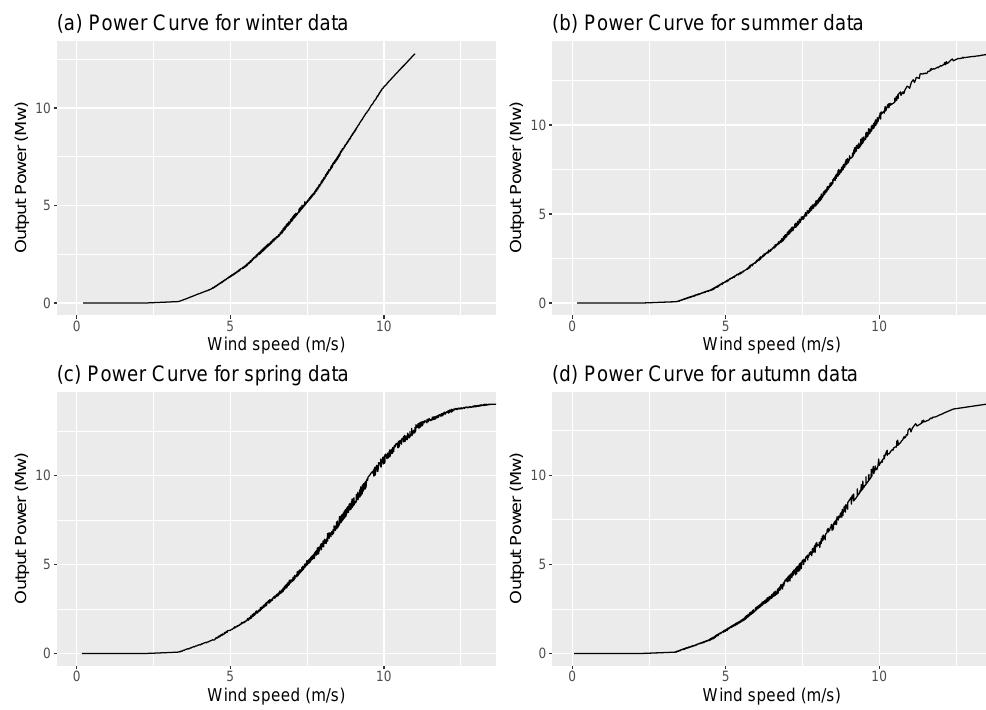
(b) Power Curve for summer data